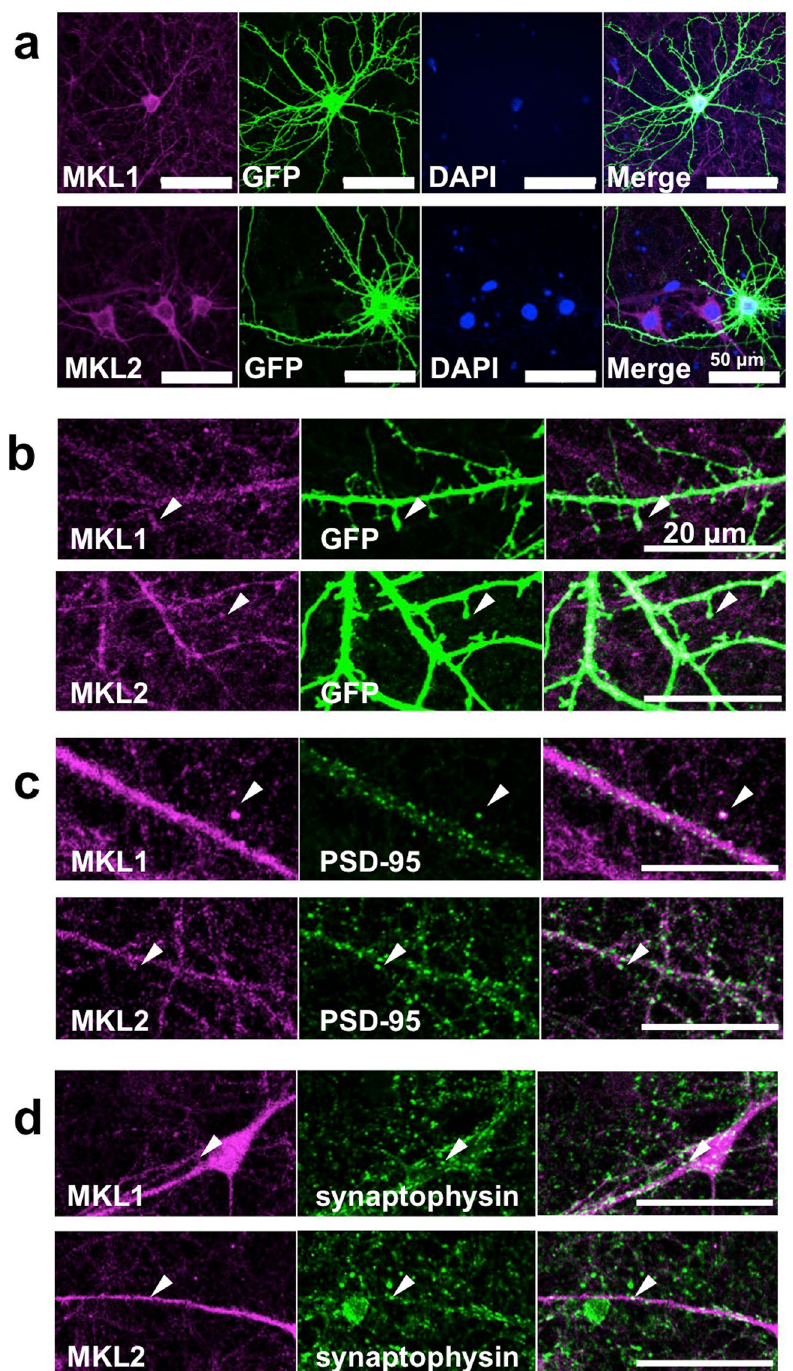
Figure 4. Immunocytochemical detection of MKL1 and MKL2 protein in cortical neurons with synapses. ( a ) Immunostaining of mature, cortical neuronal cultures. pEGFP-C1 vector (4 μ g/well) was transfected into cortical neurons at 18 days in culture. Three days later, cells were subjected to immunostaining using anti-GFP and anti-MKL1 or anti-MKL2 antibodies. ( b ) High magnification of GFP-positive cortical neurons at 21 days in culture. Arrowheads indicate dendritic spines. ( c , d ) Synaptic staining of MKL1 and MKL2 in mature, cortical neurons. Cortical neurons at 21 days in culture were immunostained using anti-MKL1, anti-MKL2, anti- postsynaptic density (PSD)-95, and anti-synaptophysin antibodies. MKL and PSD-95 signals merged. MKL and synaptophysin signals also